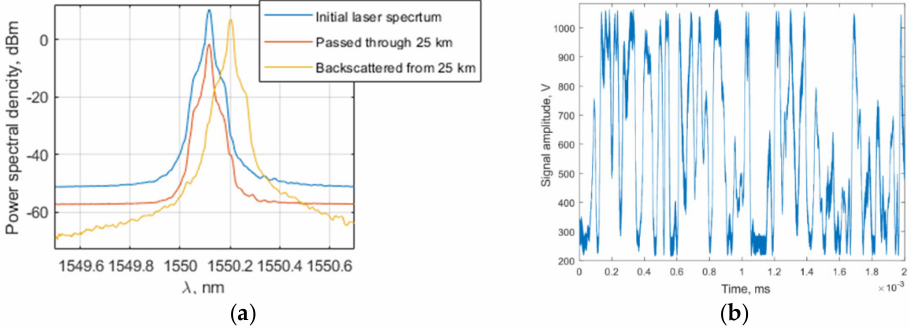
Figure 8. ( a ) Spectra of narrow-band 2 kHz laser radiation, radiation passed through 25 km of fiber and Brillouin scattering, ( b ) Plot of a signal with high Brillouin